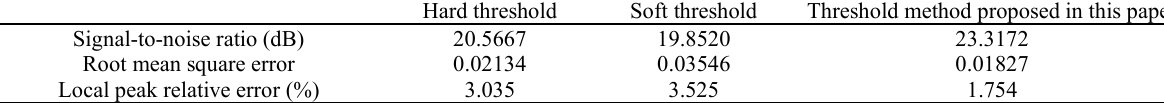
Table 1. Three threshold function denoising